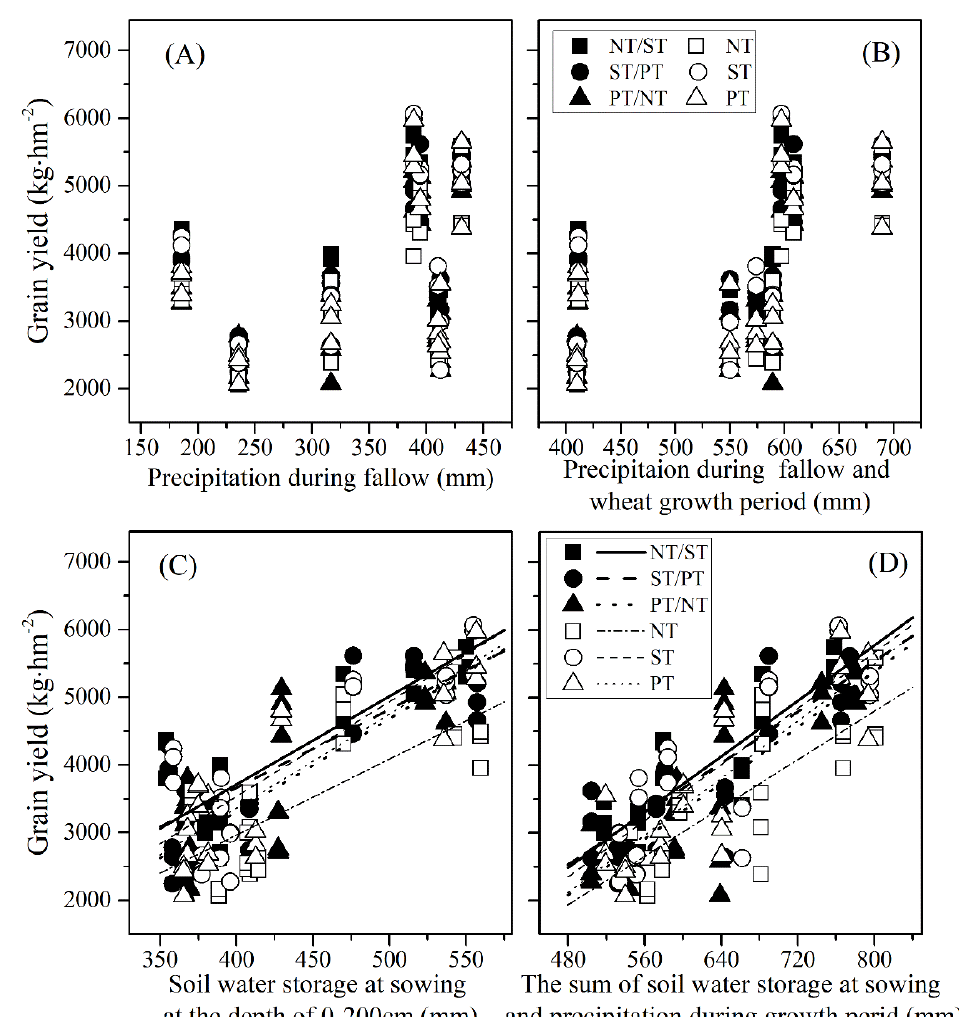
Figure 5. The relationship between wheat grain yield with precipitation during fallow ( A ), precipi- tation during the whole growth season ( B ), soil water storage at sowing ( C ) and the sum of water storage at sowing and precipitation during growth period ( D